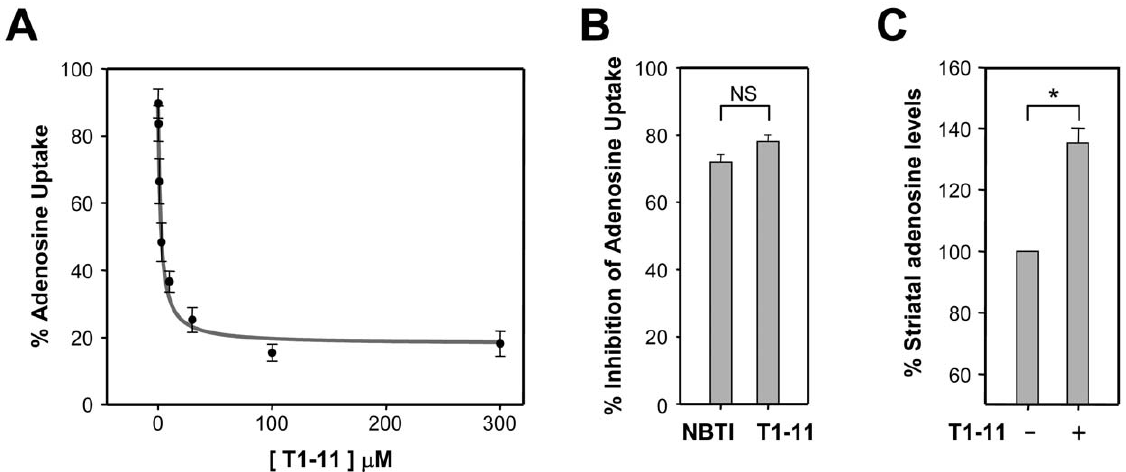
Figure 3. T1-11 inhibited the uptake of adenosine. (A) Adenosine uptake by PC12 cells was analyzed in the presence of T1-11 at the indicated concentration. (B) Adenosine uptake by PC12 cells was evaluated in the presence of T1-11 (30 m M) or NBTI (0.1 m M) as indicated for 10 min. (C) T1-11 (100 m M) was perfused throughout the dialysis probe. The collected perfusates were analyzed for striatal adenosine levels. Data points represent the mean 6 s.e.m.. * p , 0.05, compared to the basal level.